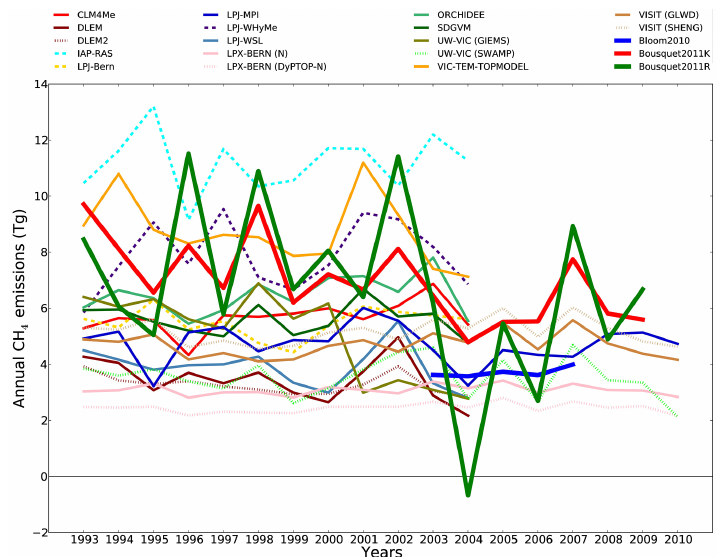
Figure 9. Time series of simulated annual total CH 4 emissions (TgCH 4 ) from participating models, the Reference and Kaplan inversions from Bousquet et al. (2011), and the Bloom (2010) inversion.